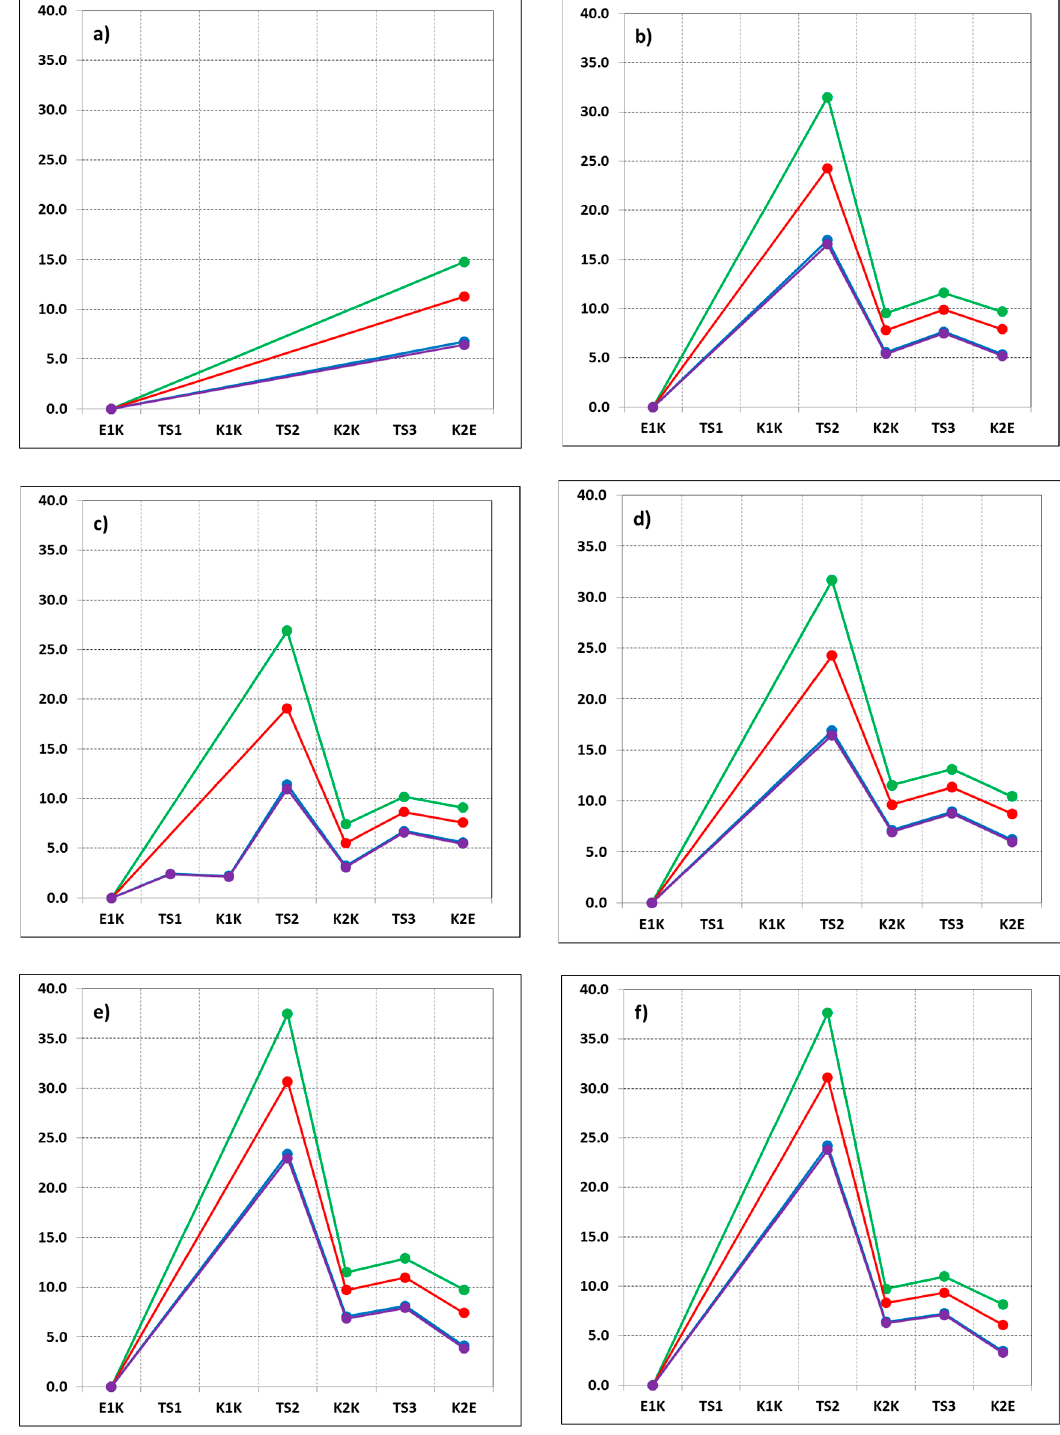
Figure 1. Ground state energy landscape (relative energies in kcal / mol units) of 4 – 7 ( a – d )) and 11 – 12 ( e , f ) in vacuum (green), toluene (red), acetonitrile (blue) and formamide (violet). The filled circles represent optimized structures.